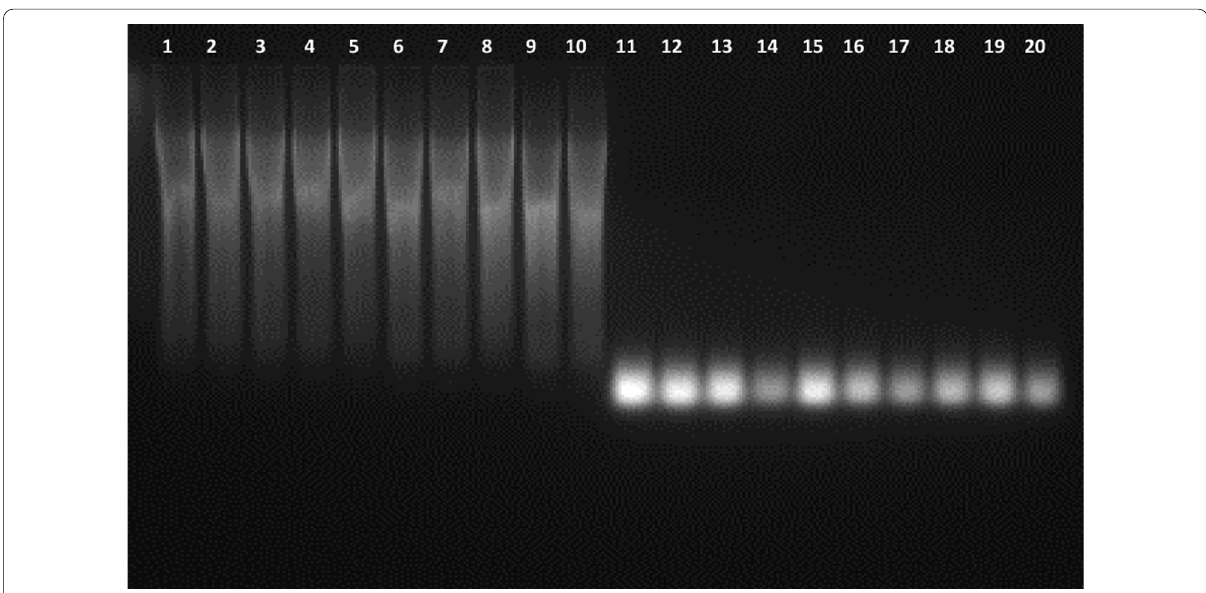
Fig. 12 Interaction of AgNPs with CT-DNA and HS-DNA. Lane 1 Control CT-DNA; Lane 2 CT-DNA AgNPs (37 °C for 30 min.); Lane = = + 3 CT-DNA Fenton’s reagent (37 °C for 30 min.); Lane 4 CT-DNA AgNPs ((37 °C for 30 min.)) Fenton’s reagent (37 °C for 30 min.); = + = + + Lane 5 CT-DNA AgNPs (37 °C for 60 min.); Lane 6 CT-DNA Fenton’s reagent (37 °C for 60 min.); Lane 7 CT-DNA AgNPs ((37 °C for = + = + = + 60 min.)) Fenton’s reagent (37 °C for 60 min.); Lane 8 CT-DNA AgNPs (37 °C for 90 min.); Lane 9 CT-DNA Fenton’s reagent (37 °C for 90 min.); + = + = + Lane 10 CT-DNA AgNPs ((37 °C for 90 min.)) Fenton’s reagent (37 °C for 90 min.). Lane 11 Control HS-DNA; Lane 12 HS-DNA AgNPs (37 °C = + + = = + for 30 min.); Lane 13 HS-DNA Fenton’s reagent (37 °C for 30 min.); Lane 14 HS-DNA AgNPs ((37 °C for 30 min.)) Fenton’s reagent (37 °C = + = + + for 30 min.); Lane 15 HS-DNA AgNPs (37 °C for 60 min.); Lane 16 HS-DNA Fenton’s reagent (37 °C for 60 min.); Lane 17 HS-DNA AgNPs = + = + = + ((37 °C for 60 min.)) Fenton’s reagent (37 °C for 60 min.); Lane 18 HS-DNA AgNPs (37 °C for 90 min.); Lane 19 HS-DNA Fenton’s reagent + = + = + (37 °C for 90 min.); Lane 20 HS-DNA AgNPs ((37 °C for 90 min.)) Fenton’s reagent (37 °C for 90 min.) = + +